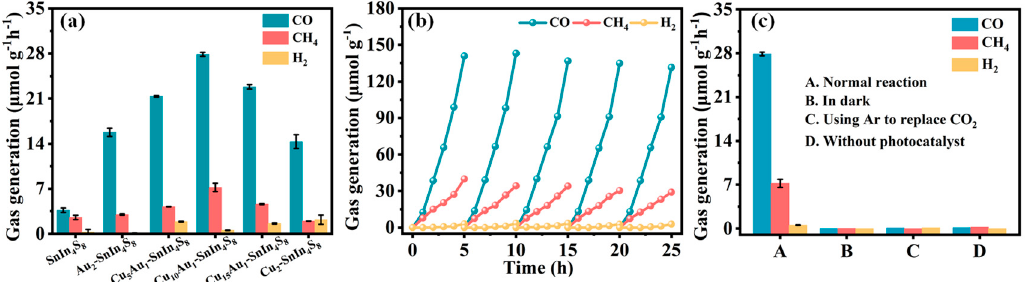
Figure 4. ( a ) CO, CH 4 and H 2 formation rates of the samples. ( b ) Long-time photocatalytic stability of Cu 10 Au 1 -SnIn 4 S 8 for 25 h. ( c ) Comparison of photocatalytic CO 2 reduction performance in differ- ent conditions. different